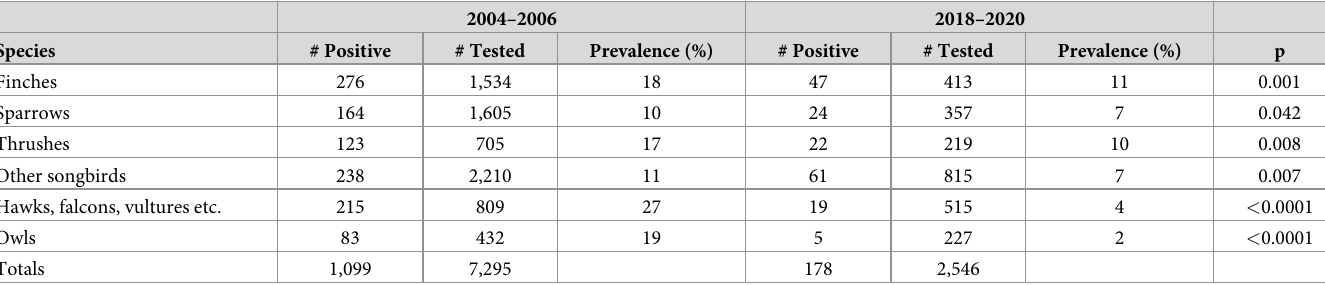
Table 5. West Nile virus prevalence in select tested dead birds, 2004–2006 compared to